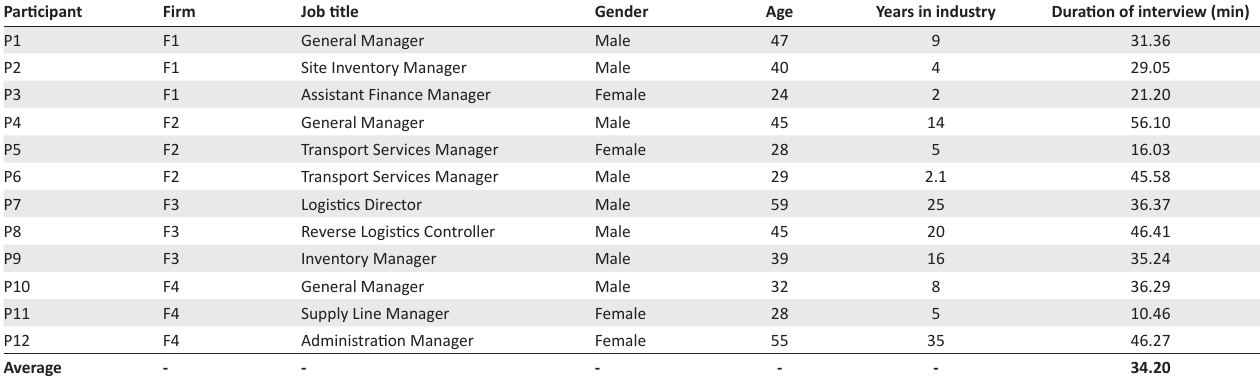
TABLE 2: Participants’ profile